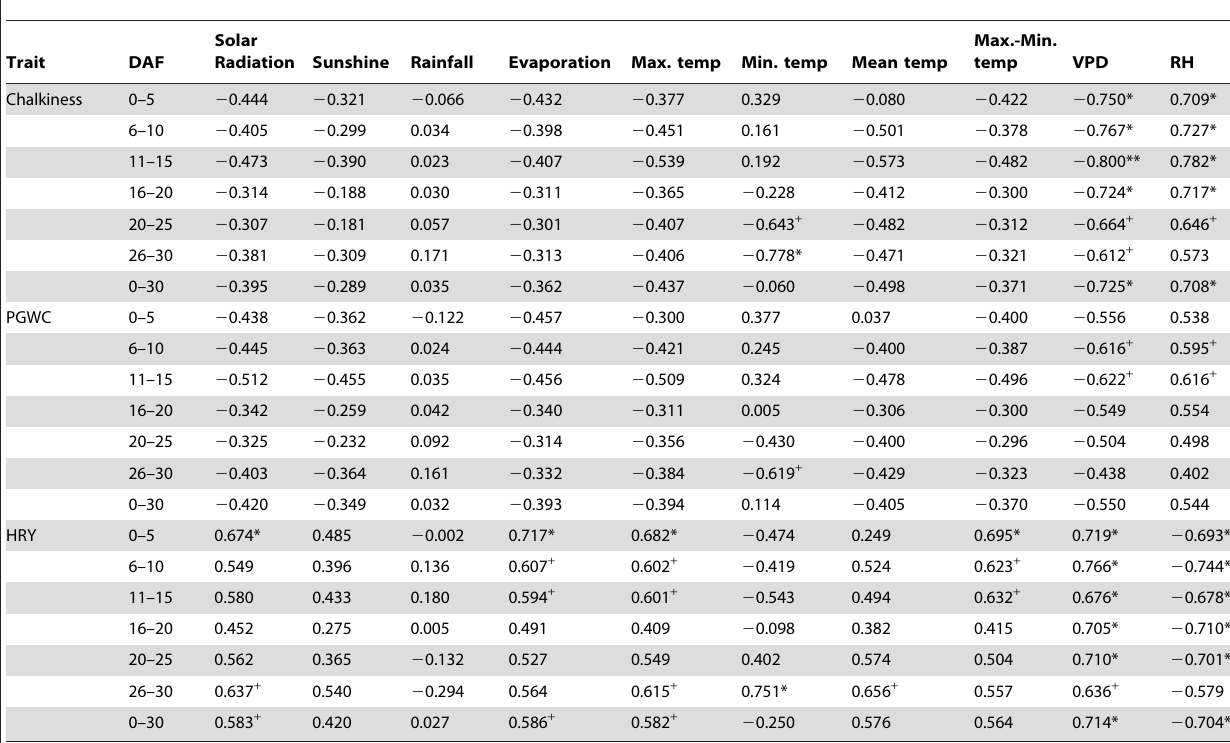
Table 4. Correlation coefficients between chalkiness, PGWC, HRY and climatic parameters during grain filling.